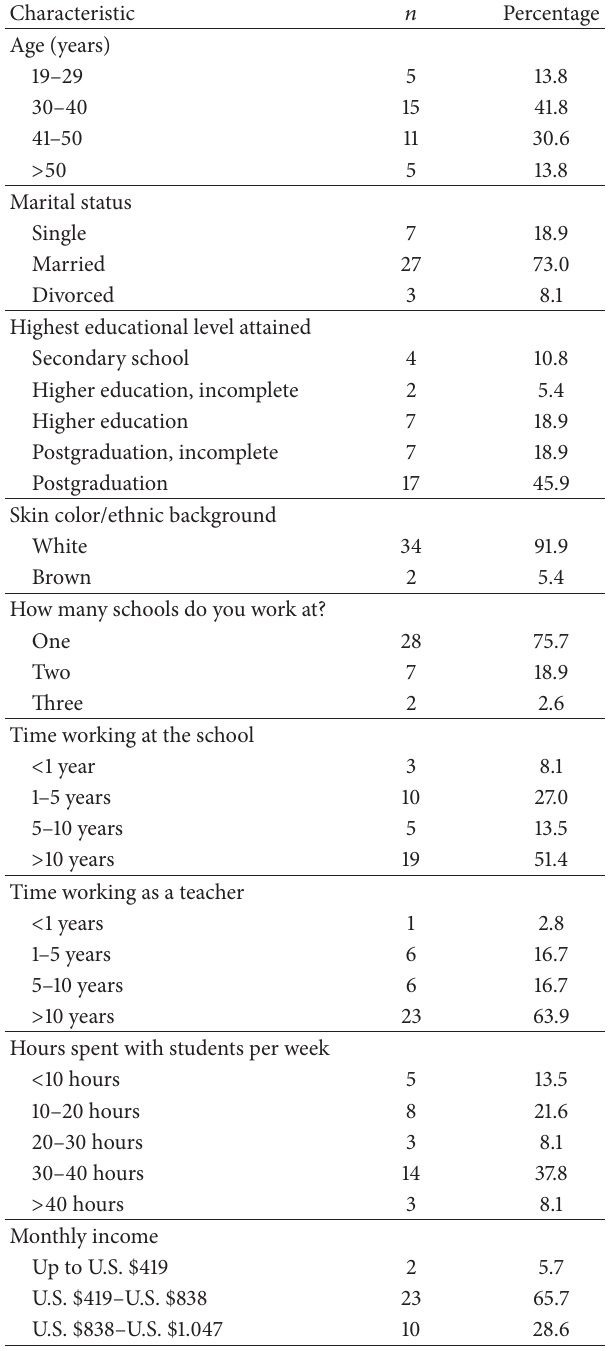
Table 1: Demographic and occupational characteristics ∗